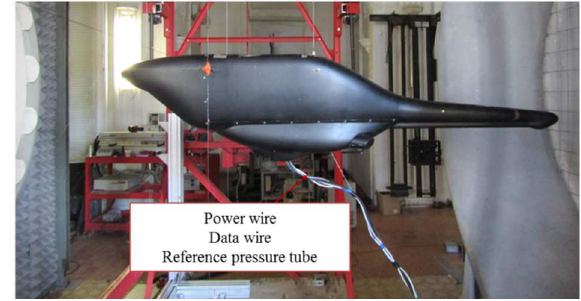
Fig. 5. The mounting of the fuselage model .